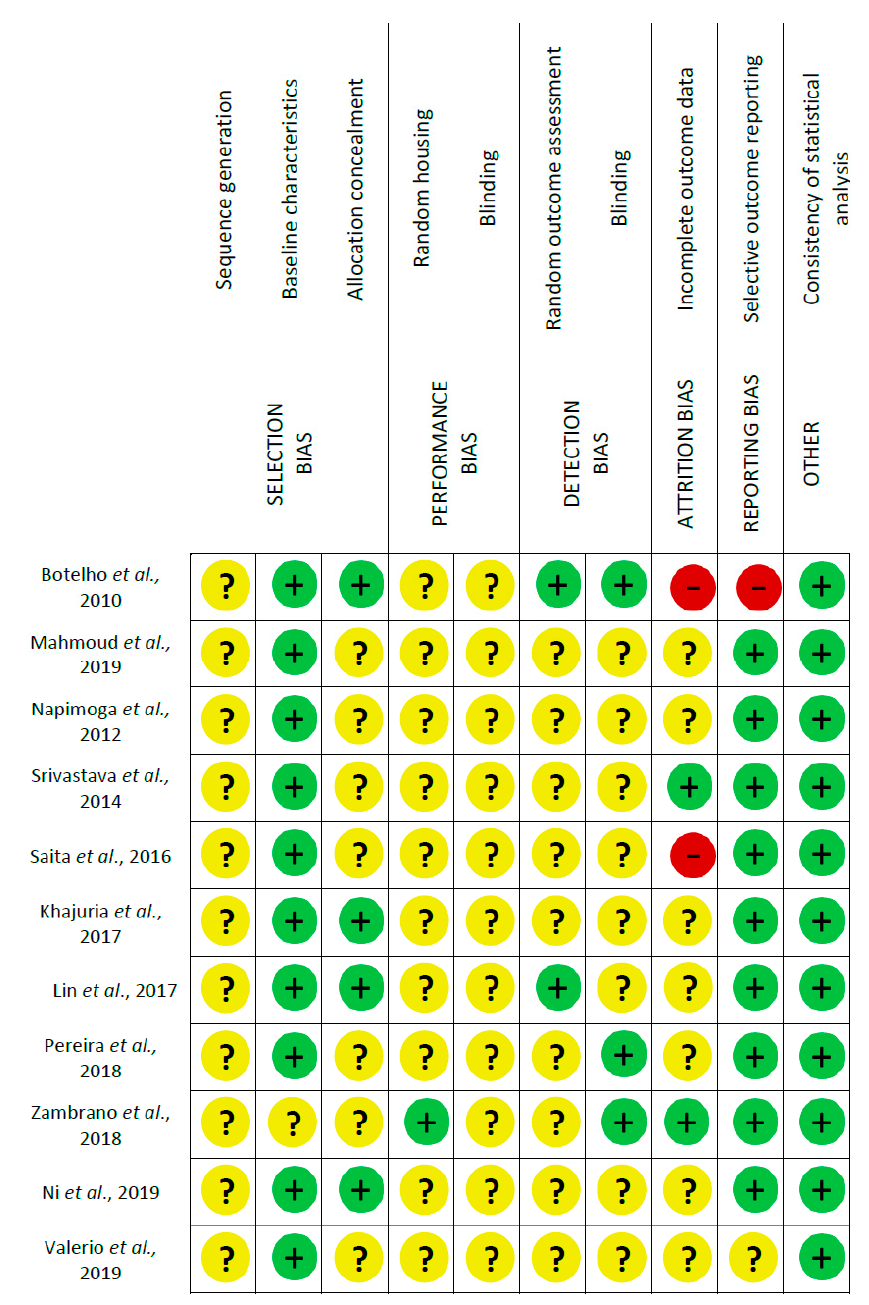
Figure 2. Risk of bias assessment evaluated according to the SYstematic Review Centre for Laboratory Animal Experimentation (SYRCLE): authors’ judgment about each risk of bias item (green = low, yellow = moderate, red = high).